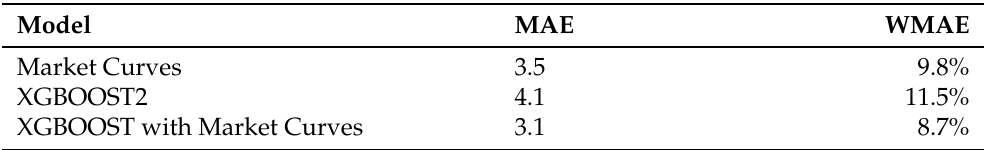
Table 3. MAE of the models when evaluated on the days where the average daily price changes by more than 3 standard deviations Model Market